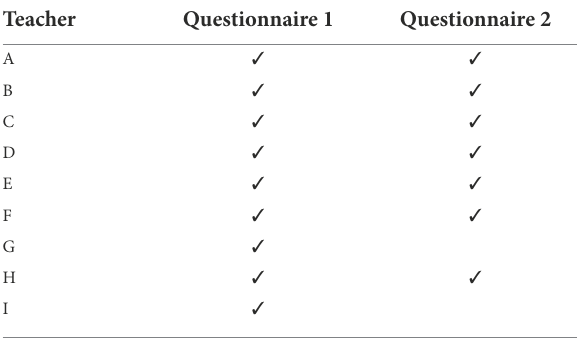
TABLE 2 Descriptive statistics of the teachers (age ranged from 31 to 41 years, experience in education from 5 to 14 years, and experience in the program from 0.5 to 10 years; these are not listed per teacher to protect